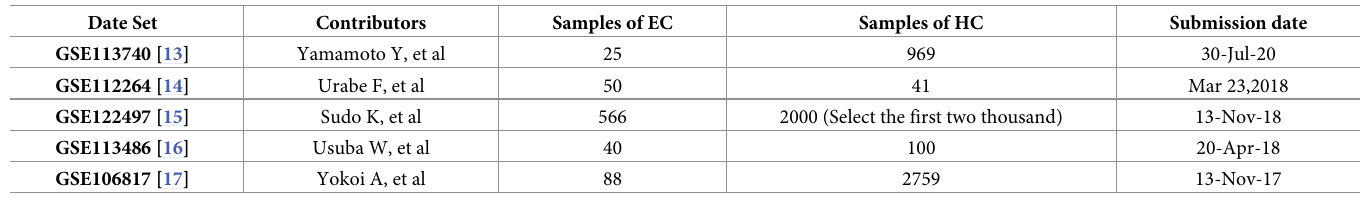
Table 1. Grouping characteristics of each data